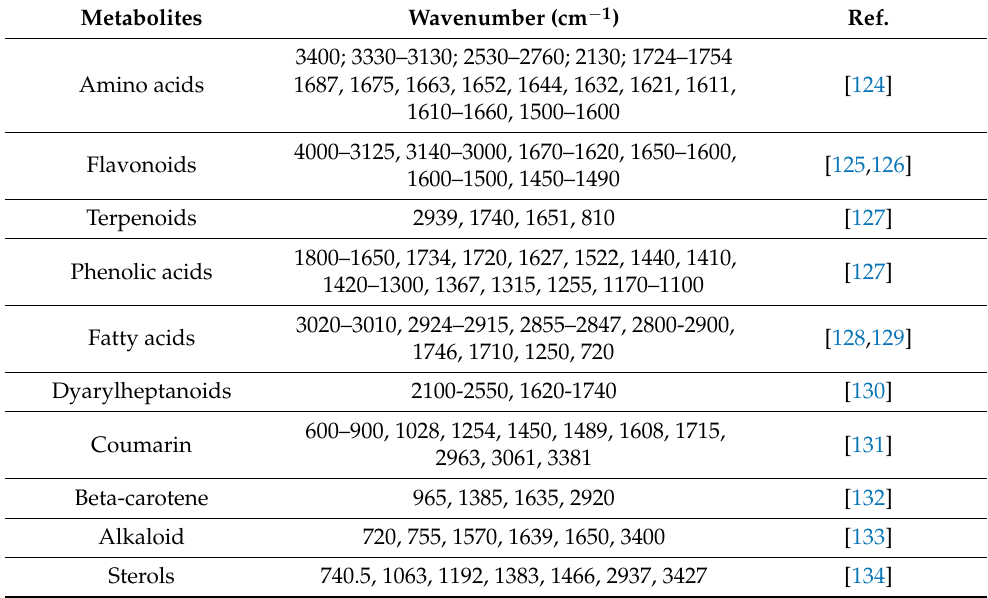
Figure 5. FT-IR spectrum of the curcuma sample and curcuma–AgNP carrier assembly. The FT-IR absorption bands identified in the curcuma sample are presented in Table 4. Table 4. The characteristic absorption bands attributed to different metabolites identified in Curcuma longa . Metabolites Wavenumber (cm − 1 )